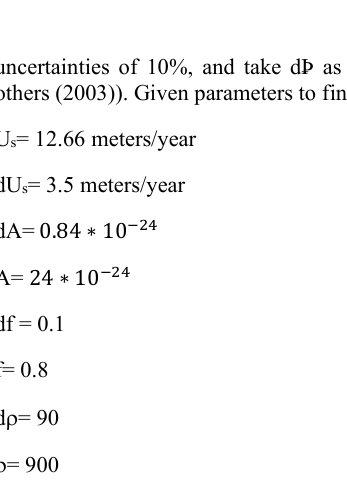
Figure 6. Thickness of Rikhasambha (G5) at 2016.